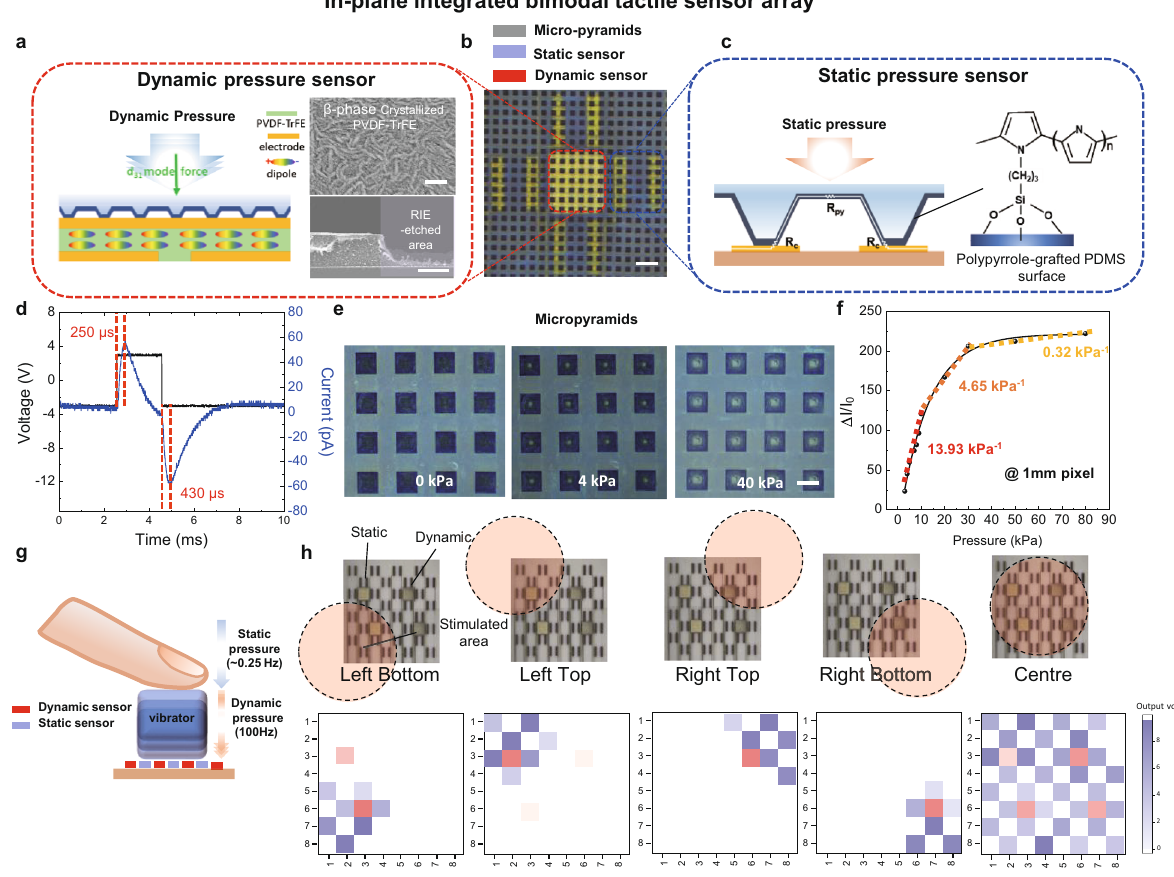
Fig. 2 Ultra- fl exible bimodal tactile sensor array for tactile acquisition. a schematic of PVDF-TrFE based dynamic pressure sensor structure and SEM surface (top), scale bar is 150 nm and cross-section image (bottom), scale bar is 3 μ m, b optical microscopic image of ultra- fl exible bimodal tactile sensor array. Scale bar is 500 μ m c schematic of static pressure sensor structure. Polypyrrole coated micropyramids come in contact with interdigit electrodes under pressure. d Response time of piezoelectric dynamic pressure sensor, the black line is the input square wave of the vibrator, the blue line is the output current of the dynamic sensor. e optical microscopic images of deformed micropyramid as the applied pressure: 0, 4, and 40 kPa, scale bar is 100 μ m. f Characteristics of piezoresistive static pressure sensor showing the change in current and resistance in the pressure range from 3 to 80 kPa. Pressure sensitivity is plotted with dotted line. g schematic of static and dynamic pressure sensing demo. h result of simultaneous monitoring of static (blue) and dynamic (red) pressure while fi ve different areas were stimulated (left bottom: LB, left top: LT, right top: RT, right bottom: RB, center: C). Spatial distribution of static pressure (blue) and dynamic pressure (red) are shown in heatmap. Red shaded circles are the areas stimulated by a 1 x 1 cm commercial loading, resulting in a decrease in the contact resistance ( R c ). As applied pressure increases from 3 to 80 kPa, the current change ( I / I 0 ) increased nearly 10 times from 23.39 to 222.17. The entire sensing range of static pressure sensor is 3 – 80 kPa, which is the recognizable pressure range of human touch 41 . The highest value of sensitivity was 13.93 kPa − 1 in the low-pressure range of 3 – 10 kPa, and the sensitivity decreased to 4.65 kPa − 1 (10 – 30 kPa) and 0.32 kPa − 1 (30 – 80 kPa) in the higher-pressure range, as shown in Fig. 2f. To demonstrate the bimodal sensing and spatial resolution of the tactile sensor array, static (~0.25 Hz) and dynamic pressure (100 Hz) were simultaneously applied to 5 different locations (left bottom, left top, right top, right bottom, center) of the sensor, as shown in Fig. 2g and Supplementary Fig. 6. Static pressure changes were measured by 32-channel static pressure sensor pixels and the dynamic vibrations were detected by the 4 channel dynamic sensor pixels. Figure 2h shows spatial distribution of static and dynamic pressure plotted by red (dynamic pressure) and blue (static pressure) heatmaps, when stimulated using a 1 cm × 1 cm commercial vibrator (PowerHap TM , TDK Corp.) such as circles shaded in red. The bimodal sensor can monitor static